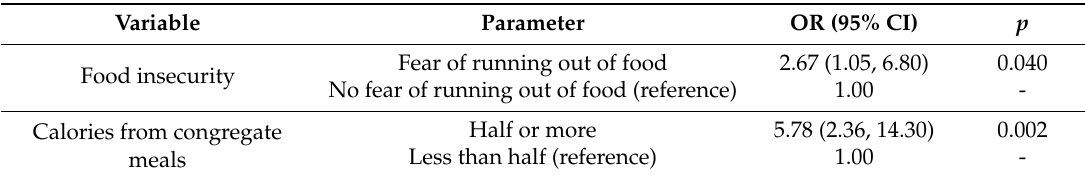
Table 6. Health characteristics and reporting that congregate meals helped independence by complex logistic